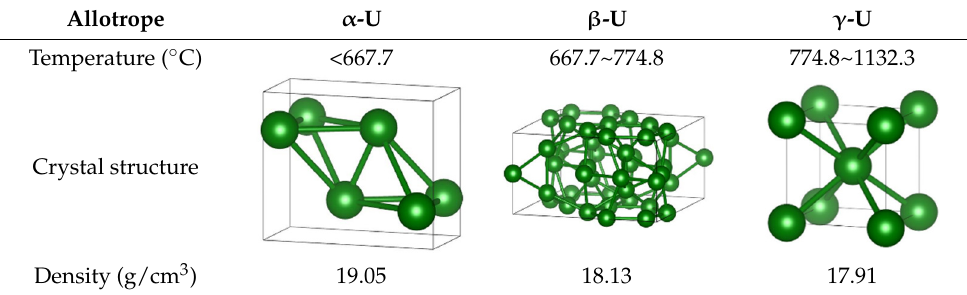
Table 1. Uranium allotropes and their characteristics, data from [17,18].